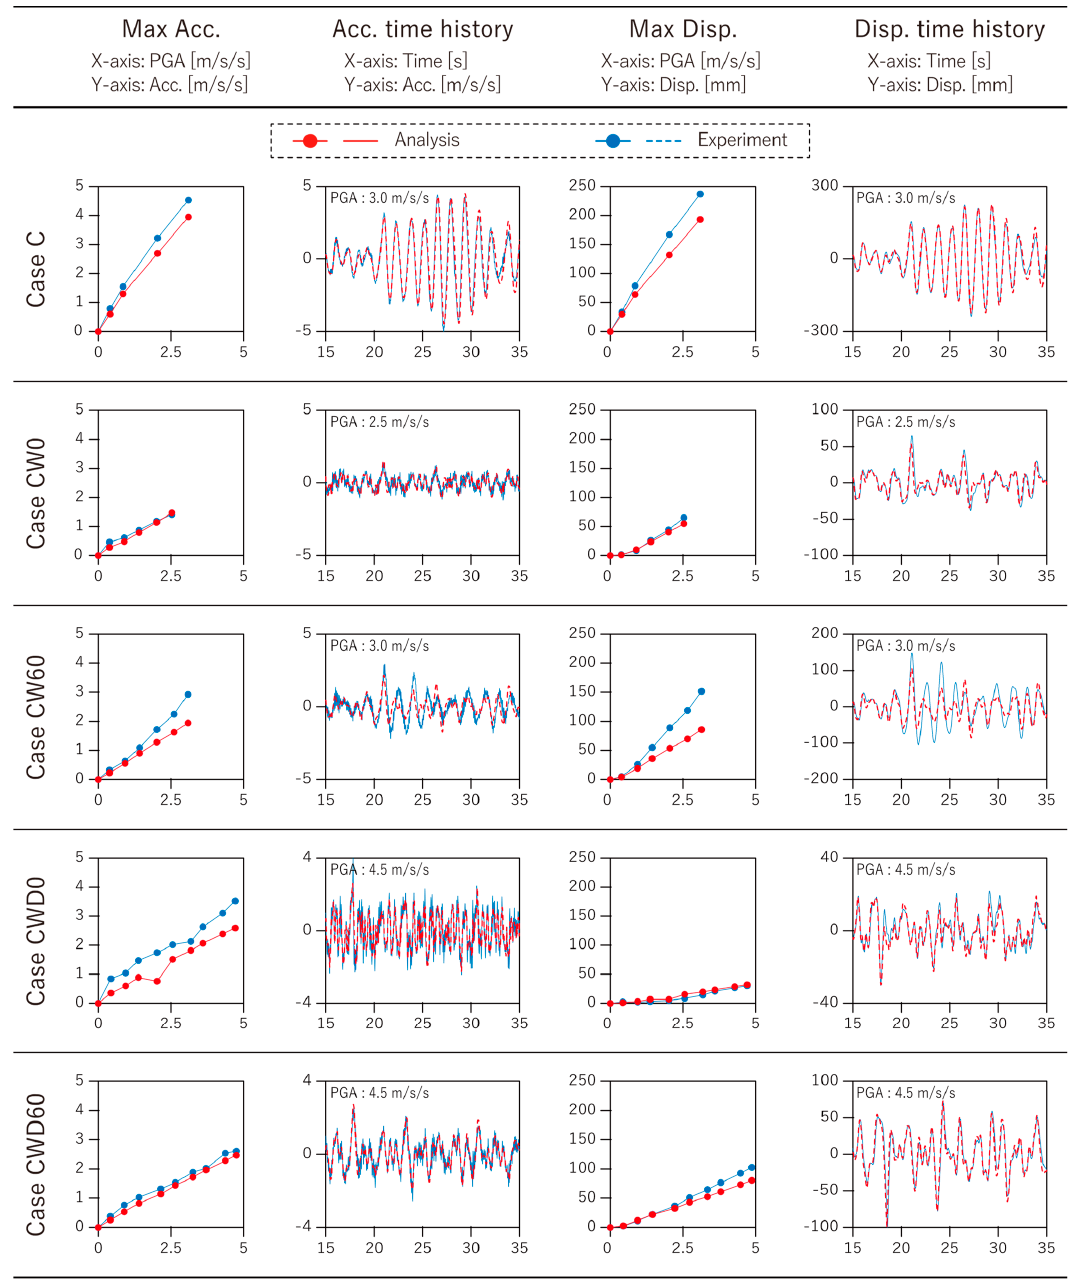
Figure 23. Results comparison of the SCS response between shake table test and simulation analysis. Table 6. Coefficient of correlation for the validation of simulation